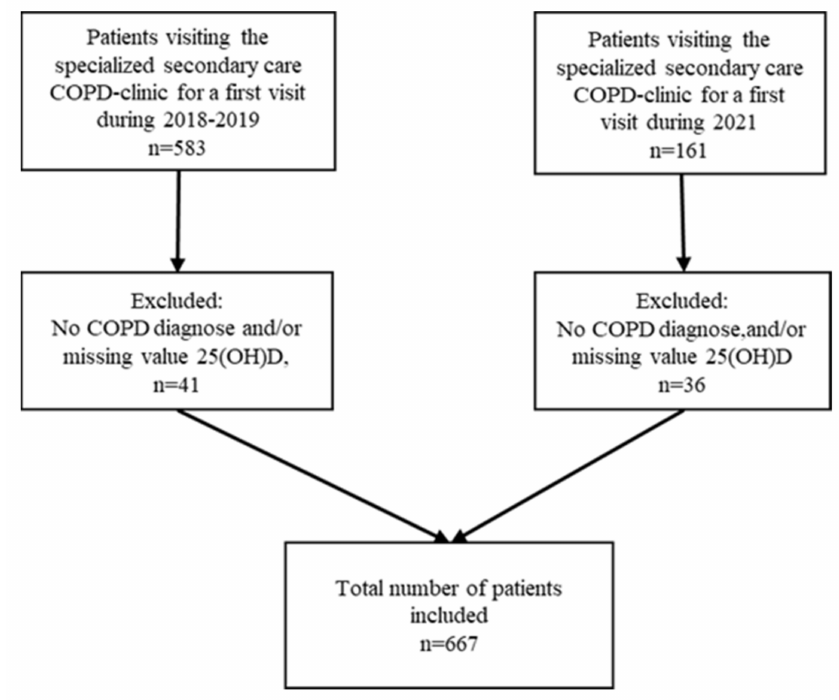
Figure 1. Flow chart of the inclusion in the study. COPD, Chronic obstructive pulmonary disease. 25(OH)D, 25-Hydroxy vitamin D. Table 1. Patient